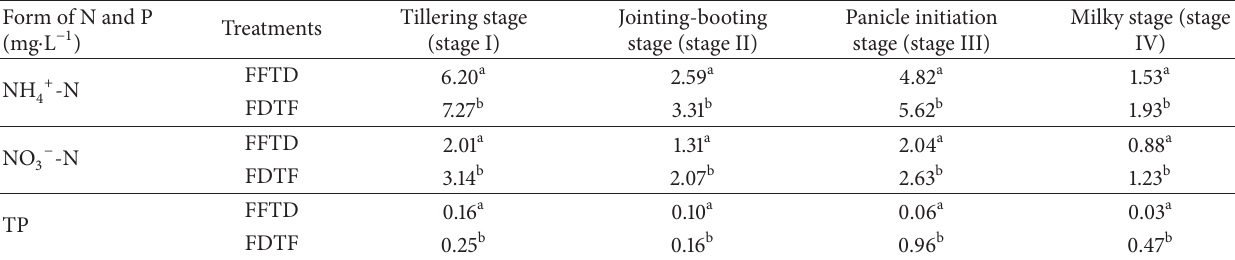
Table 2: Mean TP, NH 4+ -N, and NO 3− -N concentrations in surface water at different stages. Form of N and P (mg ⋅ L −1 )